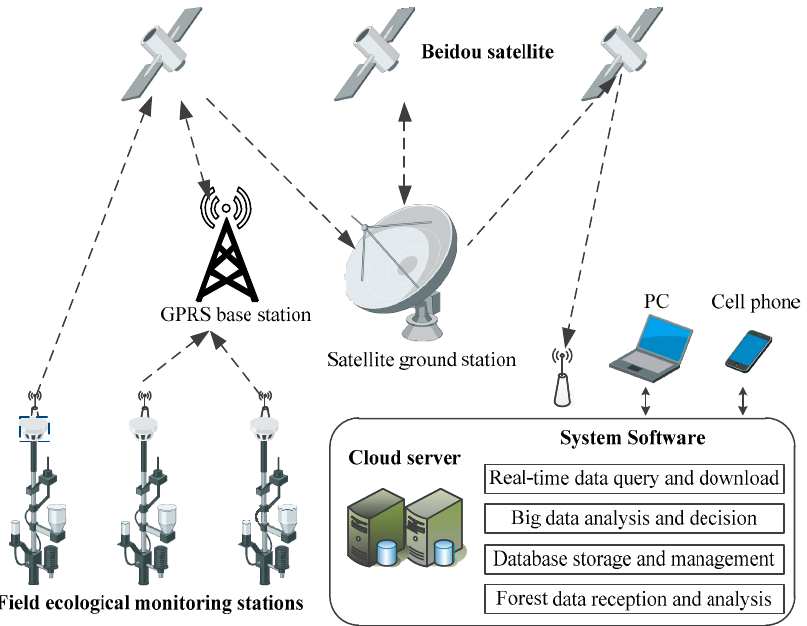
Figure 1. Schematic diagram of the field monitoring system.